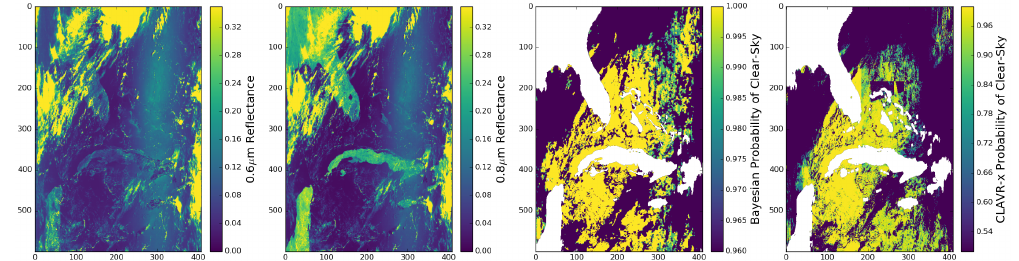
Figure 7. Bayesian and CLAVR-x clear-sky probabilities in a sunglint affected region. Data are from MetOp-A on the 1st of August 2012. From left to right, plots show the 0.6 µ m reflectance, the 0.8 µ m reflectance, Bayesian clear-sky probabilty and CLAVR-x clear-sky probability. For the clear-sky probability plots, white areas denote